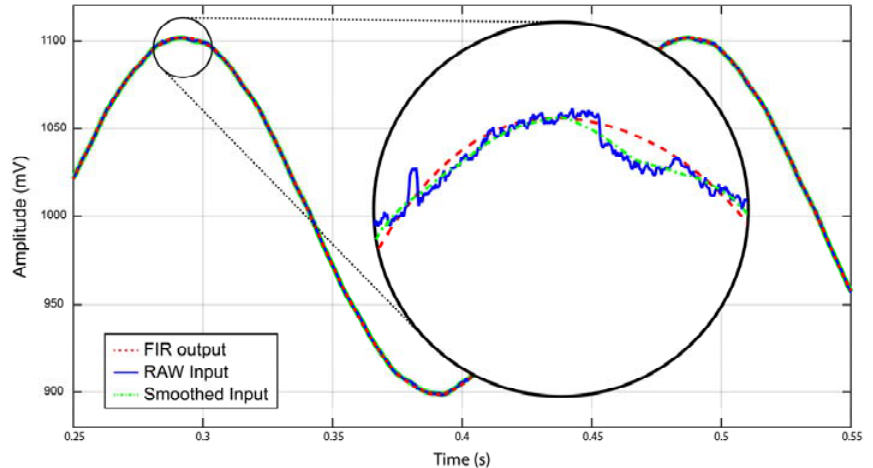
Figure 6. FIR filter response aligned with ADC RAW input data, and smoothed input data for a 100 mV 5 Hz sine modulating signal. Within the highlighted circle a zoomed portion of the signals showing the higher noise present in the input data.